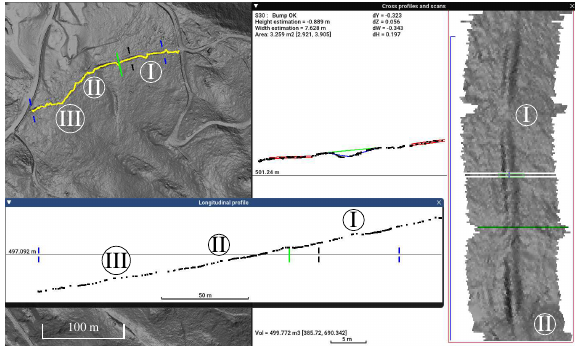
Figure 10. Analysis of a simple hollow structure. On left: main view with extracted structure on DTM shaded map; at center: bump model displayed over collected points of the selected cross profile (black); on right, processed scans centered on input stroke (green); at bottom: longitudinal point profile with measured area bounds (blue).